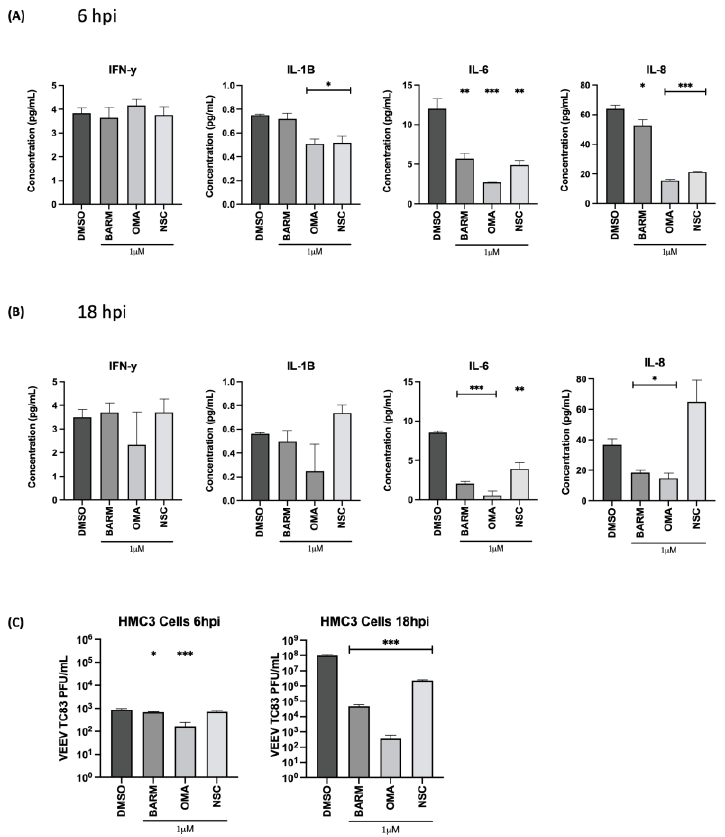
Figure 6. Effect of OMA, BARM and NSC treatment on expression of proinflammatory cytokines in the supernatants of VEEV-TC83-infected HMC3 cells. HMC3 cells were seeded in a 96-well plate format at a cell density of 10,000 cells per well. Cells were pre-treated for 1 h with inhibitors or DMSO, followed by an infection with VEEV-TC83. Following the infection, cells were treated again with the inhibitors or with DMSO. Culture supernatants were collected at 6 and 18 h post-infection ( A , B ), which were used for assessment of proinflammatory cytokine levels using MSD V-PLEX Proinflammatory Human Kit. Using this kit, 10 cytokines were quantified, namely IFN- γ , IL-1 β , IL-2, IL-4, IL-6, IL-8, IL-10, IL-12p70, IL-13 and TNF- α . The results were reported as pg/mL for each cytokine at each timepoint. ( C ) The same culture supernatants that were used for the proinflammatory cytokine quantification were also used to quantify infectious viral titer by plaque assay to establish infectivity correlates for each time point and each inhibitor. Statistical analysis was carried out using t -test * p < 0.05, ** p < 0.01, *** p <